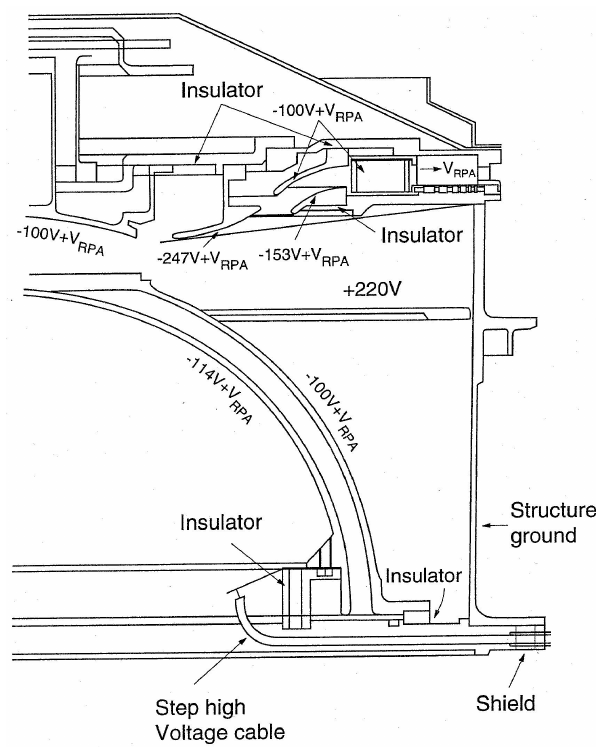
Fig. 10. Geometry of the CODIF